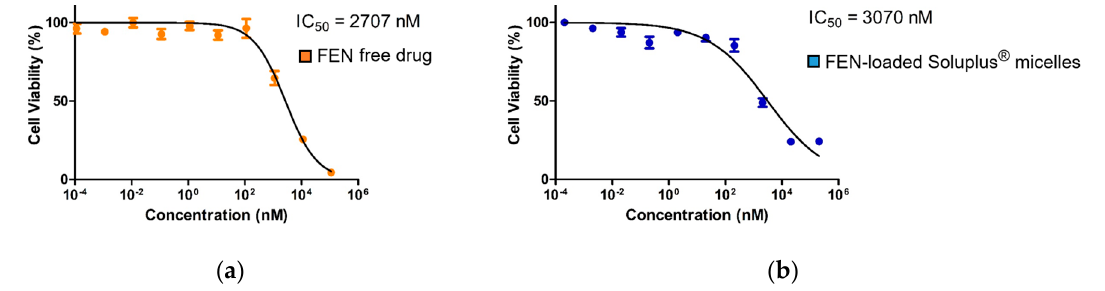
Figure 4. In vitro MTT assay results for the ( a ) free fenbendazole (FEN) drug and ( b ) FEN-loaded Soluplus ® micelle treatments of the A549 human non-small cell lung cancer (NSCLC) cell line.